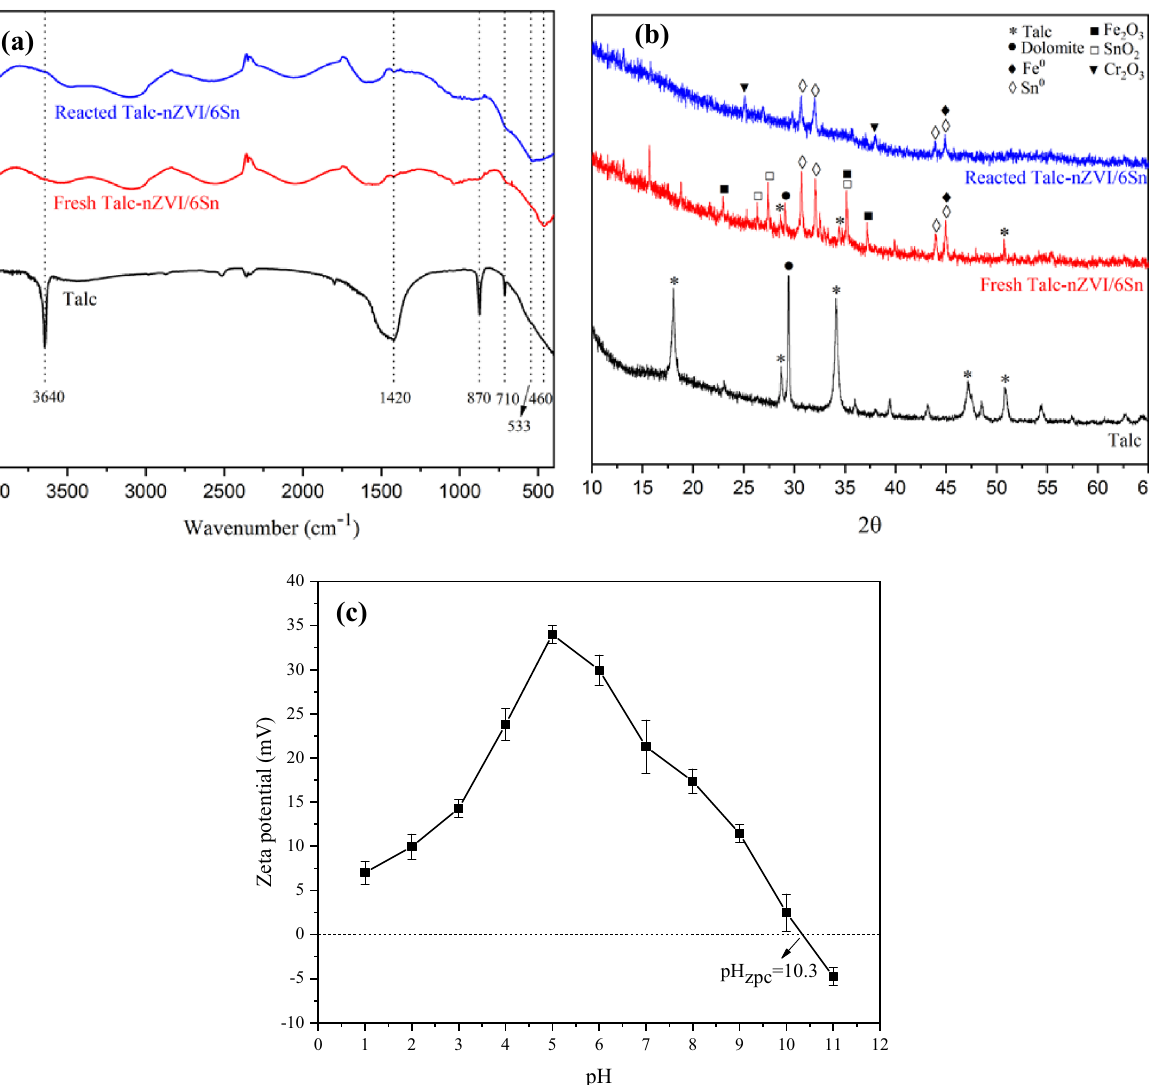
Figure 4. ( a ) FTIR spectra and ( b ) XRD patterns of Talc-nZVI/6Sn before and after Cr(VI) removal, ( c ) Zeta potential of Talc-nZVI/6Sn at different pH